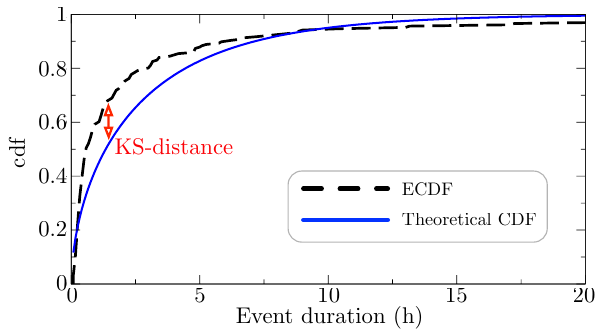
Figure 2. KS-distance diagram. ECDF is represented with a dotted black curve. CDF is represented with a continuous blue curve. The supremum of the distances between both curves is the